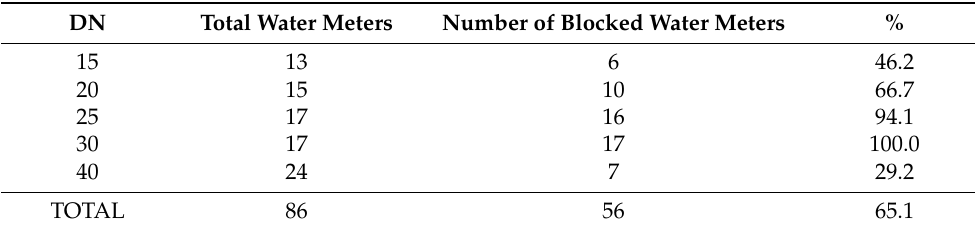
Table 6. Results of the water meter blocking test in vertical position.